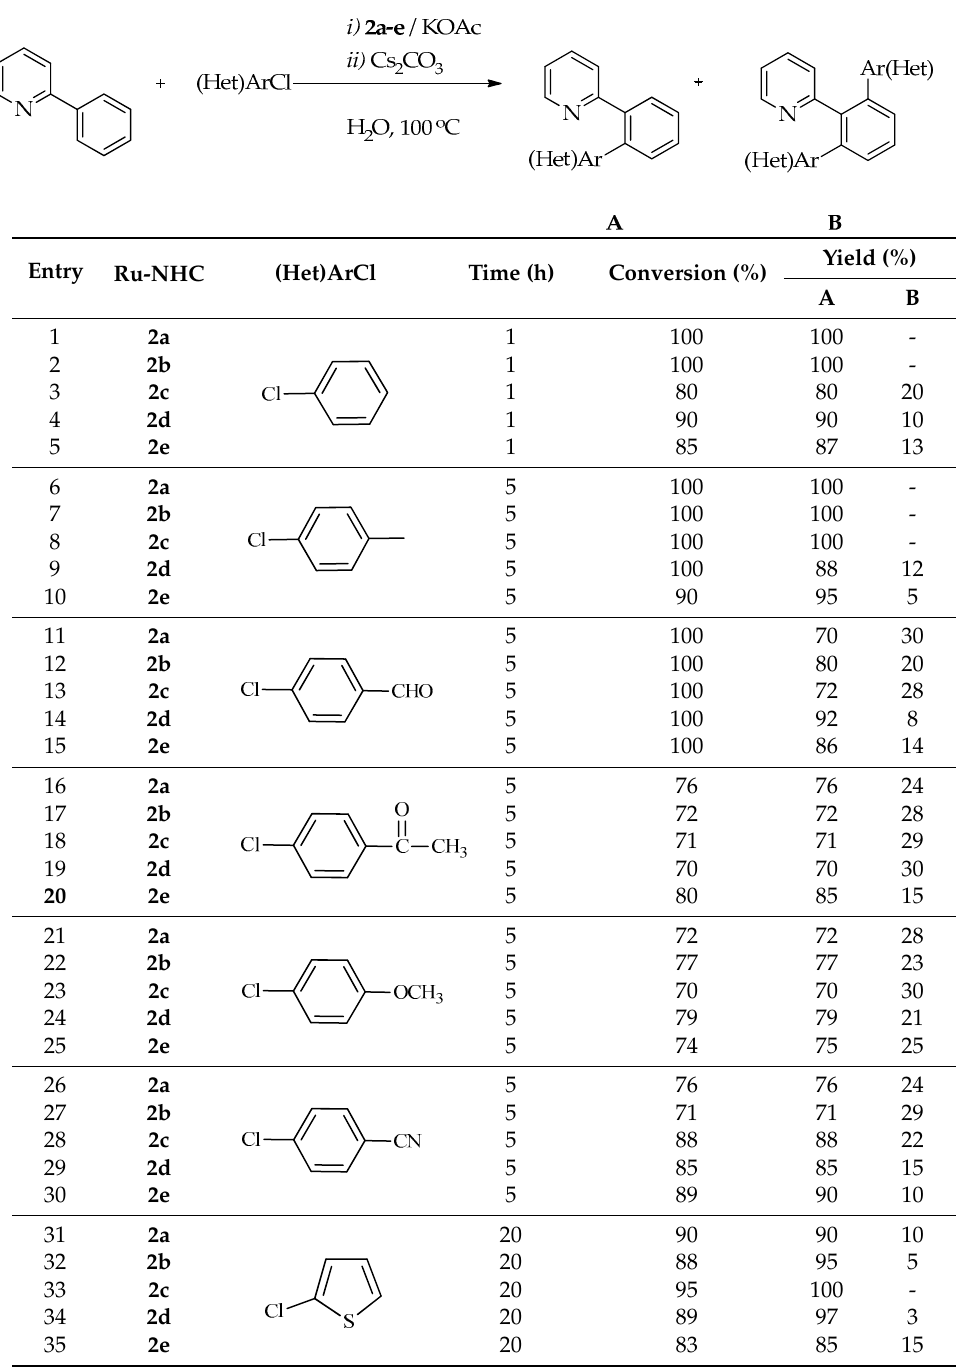
Table 4. Direct arylation of 2-phenylpyridine with (hetero)aryl chlorides catalyzed by ruthenium(II)- NHC complexes 2a – e a .